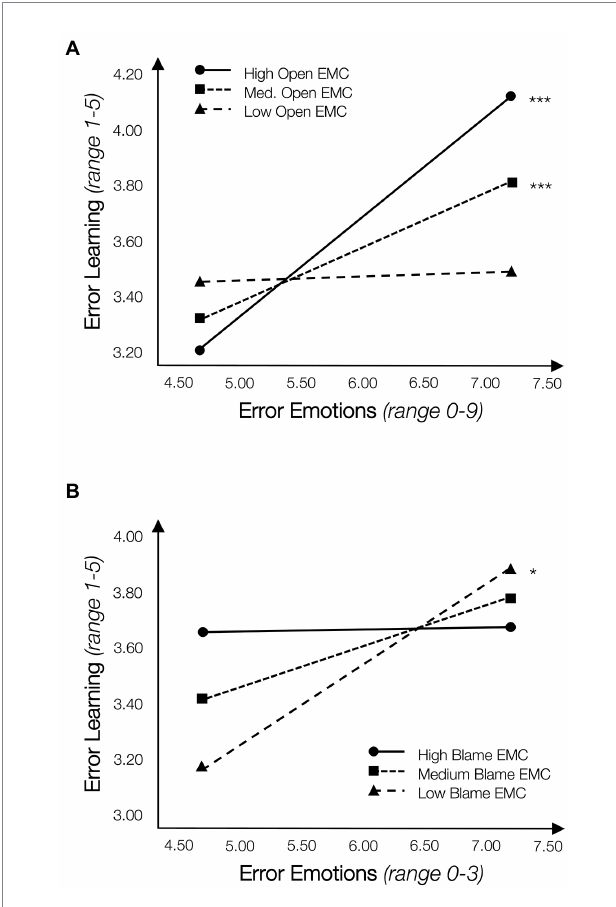
FIGURE 3 Additional analyses negative emotions and error learning. (A) Emotions × open EMC. (B) Emotions × blame EMC. N = 141; conditional effects are illustrated using the pick-a-point method, where continuous moderators are binned at M − 1SD, Mean, M + 1SD (Aiken and West, 1991; Hayes, 2018). Interactions are calculated separately for open EMC and blame EMC. We report unstandardized coefficients and p -values. Significance is indicated as + = p < 0.10, * p < 0.05, ** p < 0.01, *** p < 0.001